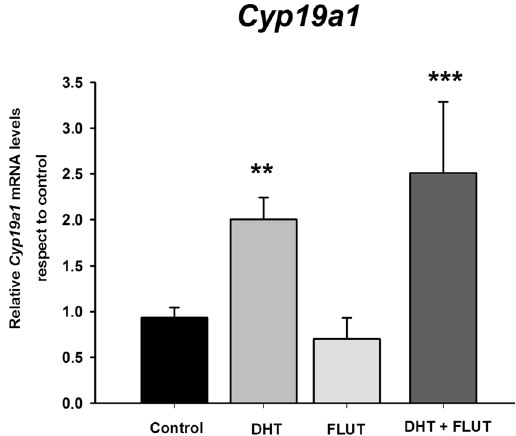
Figure 5. Effect of the selective anti-androgen flutamide on DHT-induced aromatase mRNA ( Cyp19a1 ) expression in amygdala neuronal cultures from female CD1 mouse embryos. Flutamide did not prevent the effect of DHT on aromatase expression. ** p < 0.01, *** p < 0.01. Bars indicate mean + SEM. n = 4–6 independent cultures.